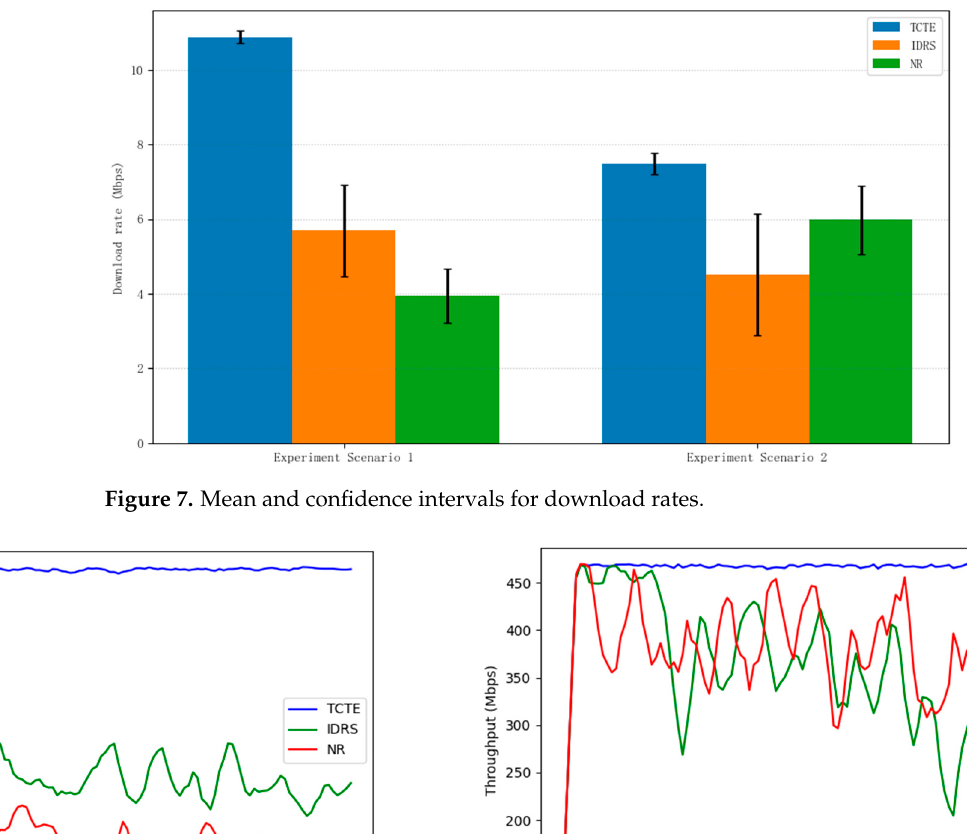
Figure 6. User download rate over time.